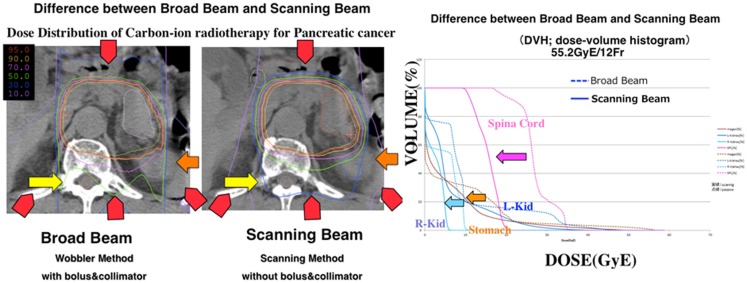
Comparison of the current passive beam modulation treatment plan with a spot scanning treatment plan for LAUPC. In the right panel, the dose–volume histogram for different organs is shown for passive modulation (dotted line) and raster scanning (solid line). Dose to the spinal cord and kidney are highly reduced. Potential reduction is also clear for stomach and duodenum, whose movements are, however, critical.